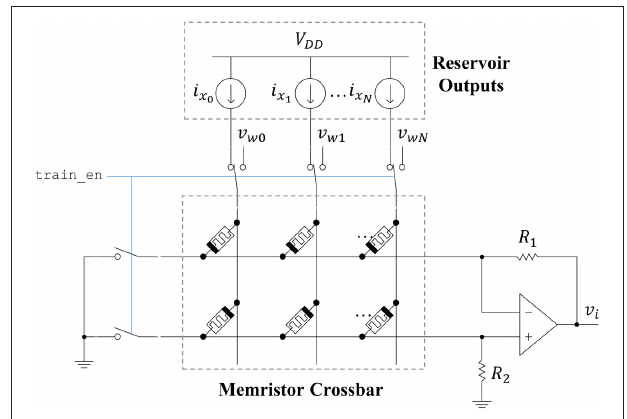
FIGURE 9 | Readout circuit for a single ESN output. A memristor crossbar provides trainable weights to the linear output